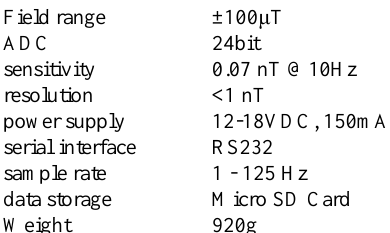
Figure Battery driven UAS (md4-1000 microdrones, Germany).